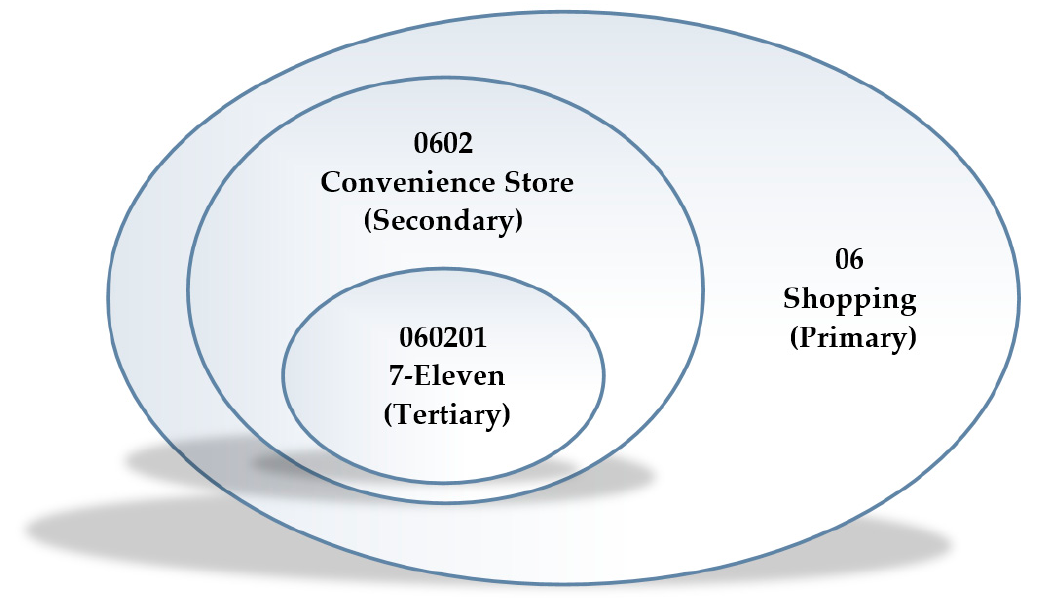
Figure 3. A Gaode POI record with a category code of 060201 in the three-level category coding system.